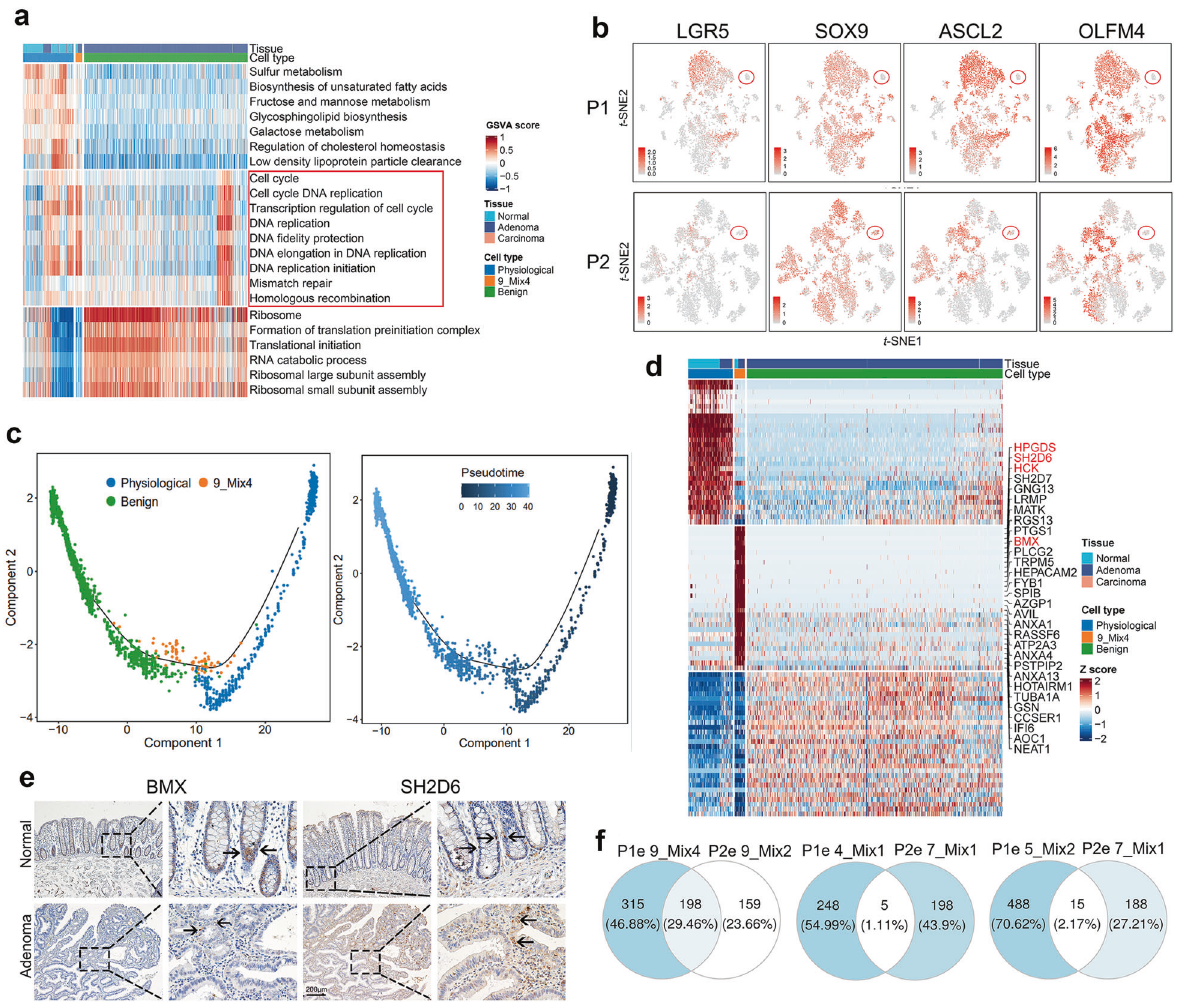
Fig. 4 Intermediate stages of epithelial cells among the physiological, benign, and malignant stages. a Signature scores for cells from physiological, benign, and mixed clusters (9_Mix4) in P1. Columns represent cells ( n = 2420) annotated with cell type and tissue. Colors represent Z scores. b Log-normalized expression levels of key marker genes of intestinal stem and base crypt cells ( LGR5, SOX9, ASCL2, OLFM4 ). Red cycle indicates cells of cluster 9_Mix4 (top, P1, n = 73) and cluster 9_Mix2 (bottom, P2, n = 87). c Single-cell trajectory of 554 physiological epithelial cells, 73 adenoma-precursor cells (cluster 9_Mix4), and 1793 benign epithelial cells. The trajectory was constructed using monocle according to gene expression. Each dot represents a single cell, and colors represent cell types (left) and the pseudotime of trajectory (right). d Heatmap of differentially expressed genes among normal, adenoma precursor (cluster 9_Mix4), and adenoma epithelial cells. Genes related to carcinogenesis are highlighted. e Representative images of BMX and SH2D6 IHC staining of normal tissue ( n = 20) and adenoma ( n = 20). Black arrows indicate positively stained cells. Scale bar, 200 μ m. f Venn diagrams show the overlap of upregulated genes in P1 epithelial mixed clusters (cluster 4, 5, and 9) and P2 epithelial mixed clusters (cluster 7 and 9) consistent with the physiological functions of intestinal epithelial Gene set variation analysis (GSVA) deciphered the physiological cells. In benign epithelial populations, signatures of ribosome and pathological signals of the three cell types (Fig. 3g and assembly and translational initiation were enriched, implying that Supplementary Fig. 6g). Signatures of nutrition absorption and protein synthesis is a major feature at the stage of benign metabolism were enriched in normal cell populations and were Signal Transduction and Targeted Therapy (2022)